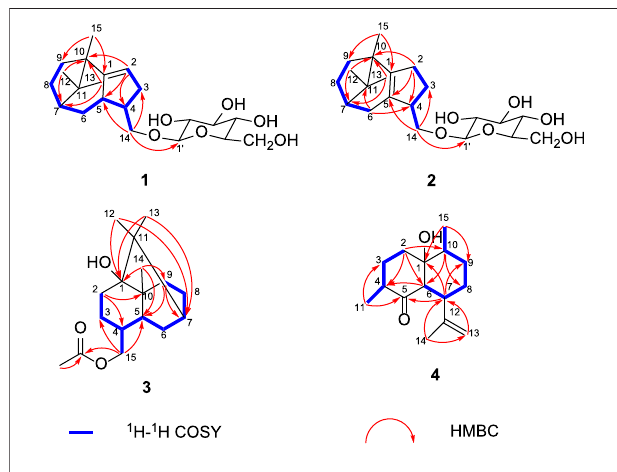
FIGURE 1 | Key 1 H- 1 H and HMBC correlations.